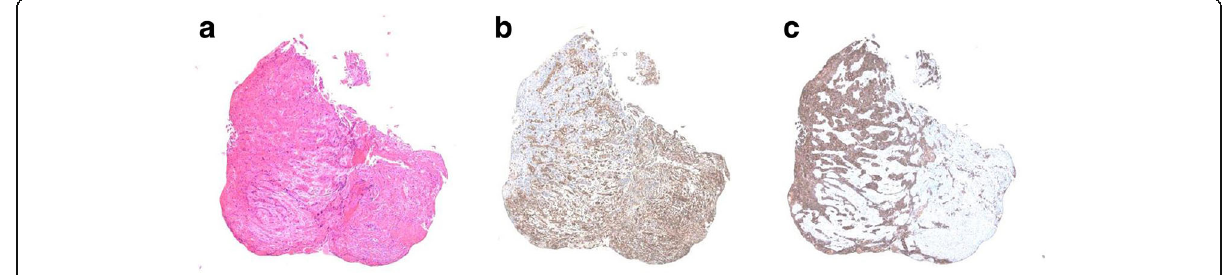
Fig. 2 Microscopic and immunohistochemical findings of a biopsy specimen from the tumor. a The histological findings of the biopsy specimen showed squamous cell carcinoma with spindle cell components. b , c Immunohistochemical evaluation of the biopsy specimen revealed that the squamous cell carcinoma cells were positive for pan-cytokeratin, while the spindle cells were positive for vimentin. a Hematoxylin and eosin, b vimentin, and c pan-cytokeratin (× 40)